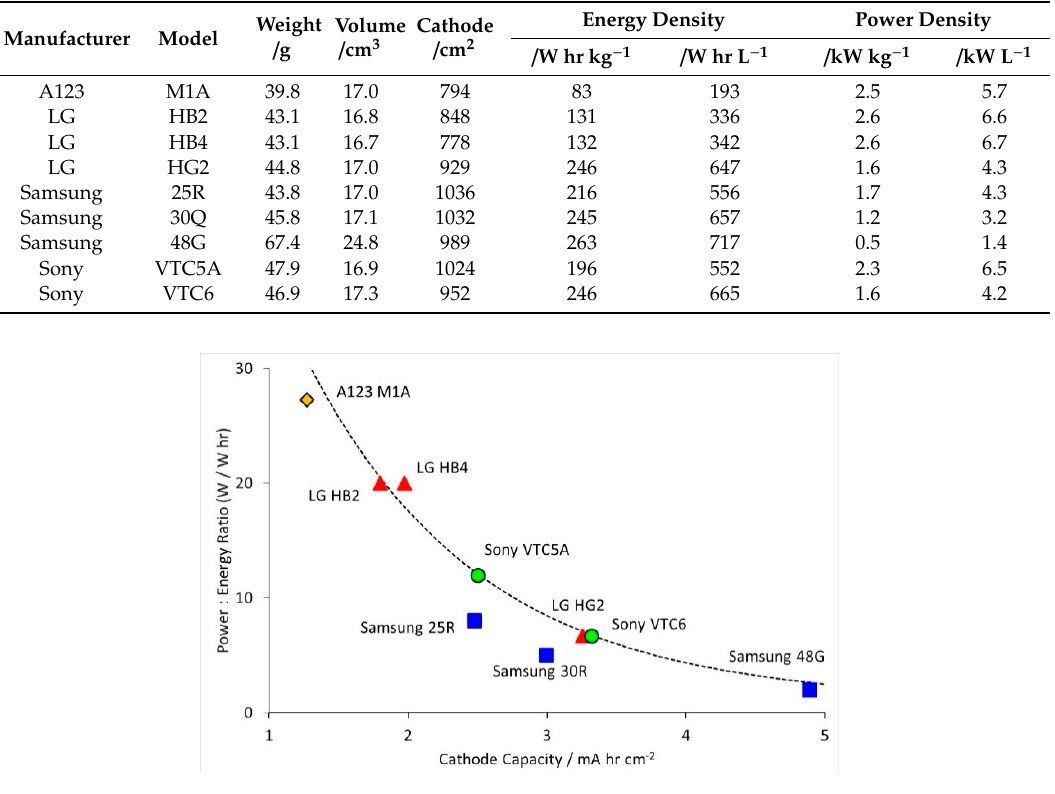
Figure 2. Correlation between power – energy ratios and areal capacities.